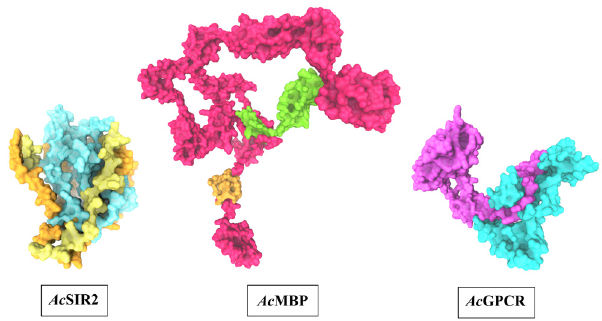
Figure 3. The predicted three-dimensional structures of Ac SIR2, Ac MBP, and Ac GPCR. Ac SIR2: blue represents the SIR2 superfamily region, yellow represents the YEATS family region. Ac MBP: Orange represents transmembrane proteins; green represents a domain of an unknown function. Ac GPCR: purple represents Lung seven-transmembrane receptor. Ac SIR2, A. castellanii Sir2 family protein; Ac MBP, A. castellanii mannose- binding protein; Ac GPCR, A. castellanii G protein-coupled